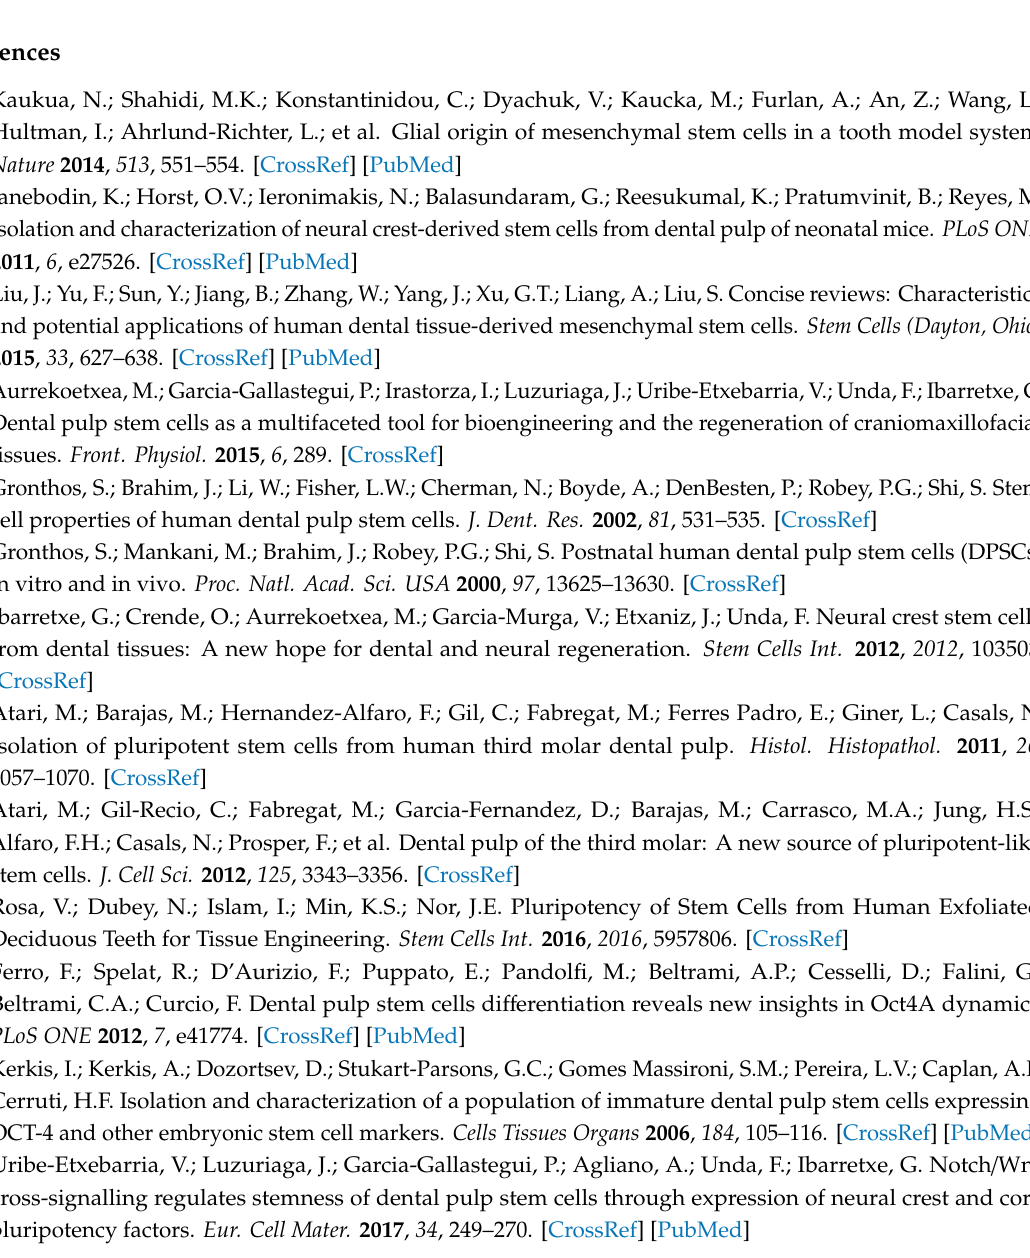
Figure S1: Expression of cell di ff erentiation markers and pluripotency core factors in DPSCs and